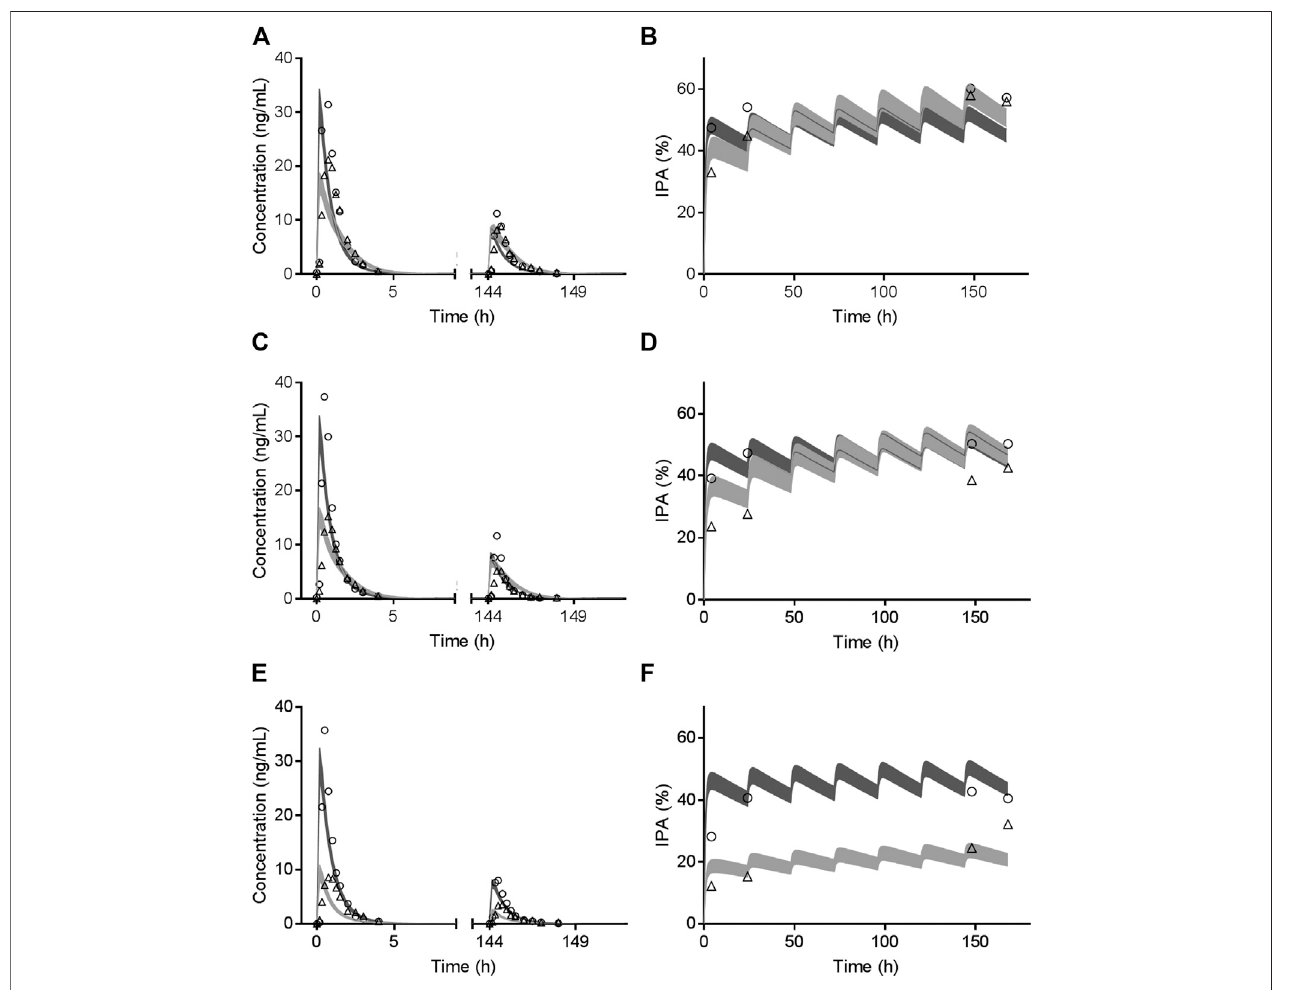
FIGURE4| Observedmeanvalue(symbols)andsimulated95%con fi denceinterval(bands)ofAM-H4concentration (leftrow) andIPA (rightrow) vs.timeamong CYP2C19 EM (A and B) , IM (C and D) and PM (E and F) population receiving clopidogrel or vicagrel.